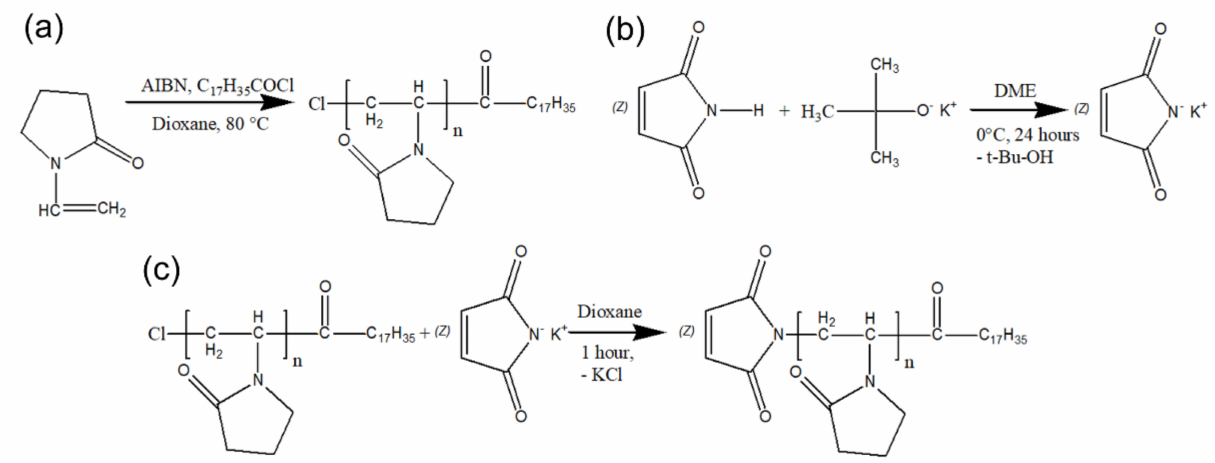
Figure 1. The synthesis schemes of compounds for further preparation of Amph-PVP nanoparticles: ( a ) Amph-PVP-Cl polymer; ( b ) potassium maleimide; ( c ) Amph-PVP-Cl modification by maleimide